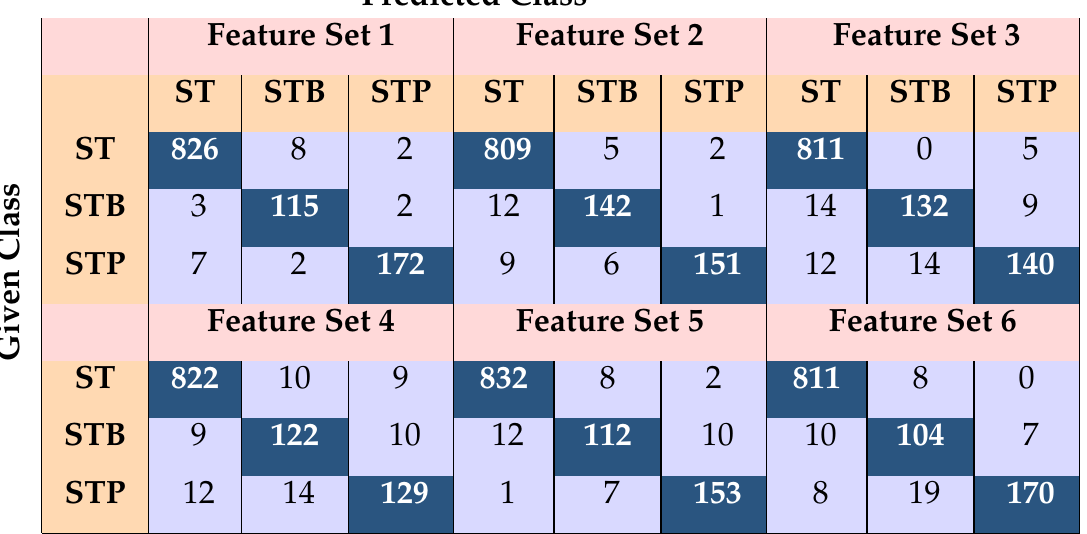
Table 5. The confusion metrics of the random forest (RF) classifier over the 12 s window size on six feature sets at the left-hand (LH)